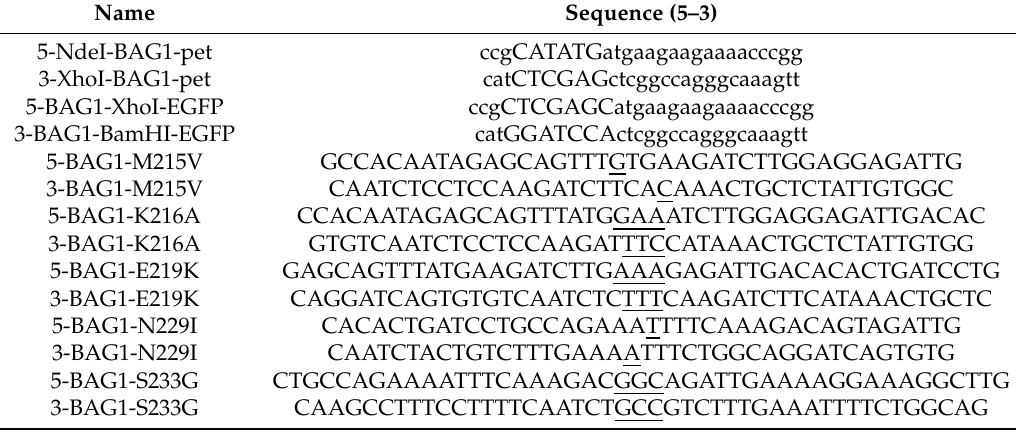
Table 7. The sequences of the oligonucleotide primers used in the present study. The restriction enzymes sequences are capitalized, and the mutated nucleotides are